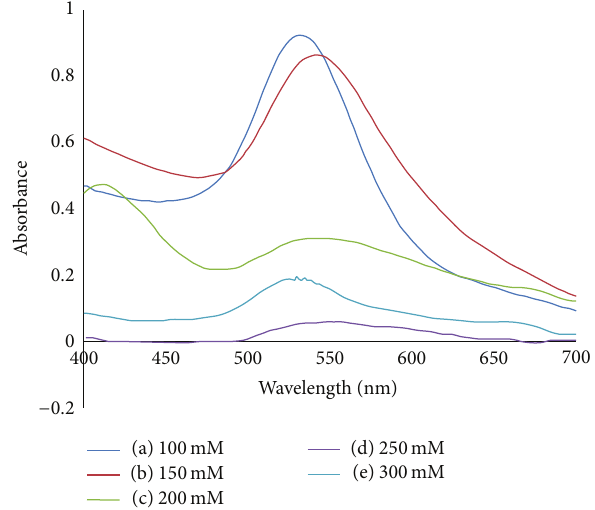
Figure 9: Absorption spectra of chitosan capped AuNPs with various concentrations of reducing agent MSG after 1 month aging time: (a) 100mM; (b) 150 mM; (c) 200 mM; (d) 250 mM; (e) 300 mM.